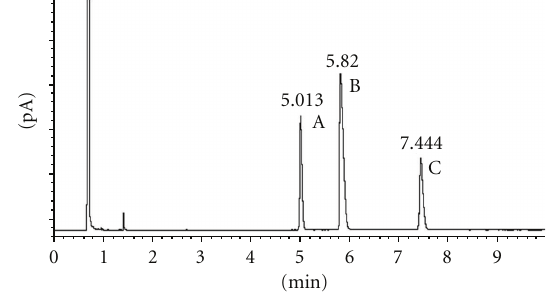
Figure 1: Chiral GC analysis of 2-heptyl acetate. (A) ( S )-2-heptyl